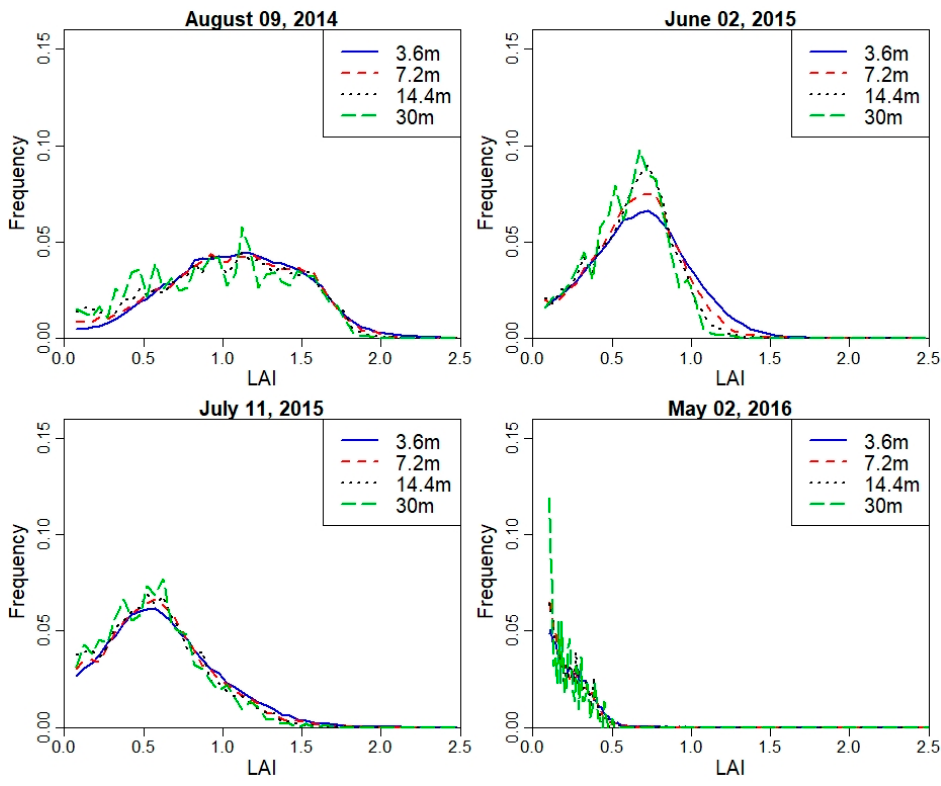
Figure 10. Frequency curve of LAI at different times from 3.6 m and 7.2 m, 14.4 m and 30 m.